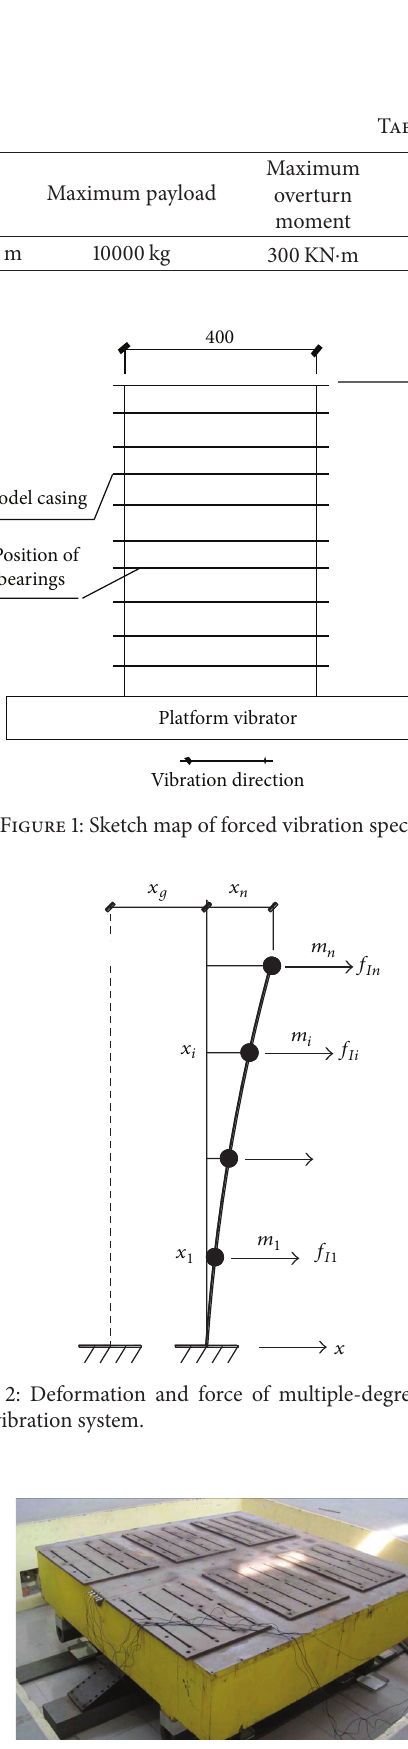
Figure 3: Vibrating table.